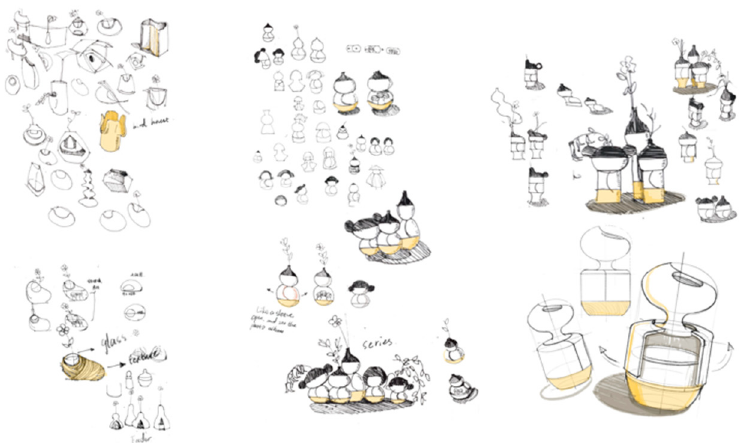
Figure 2. Sketch with design process.